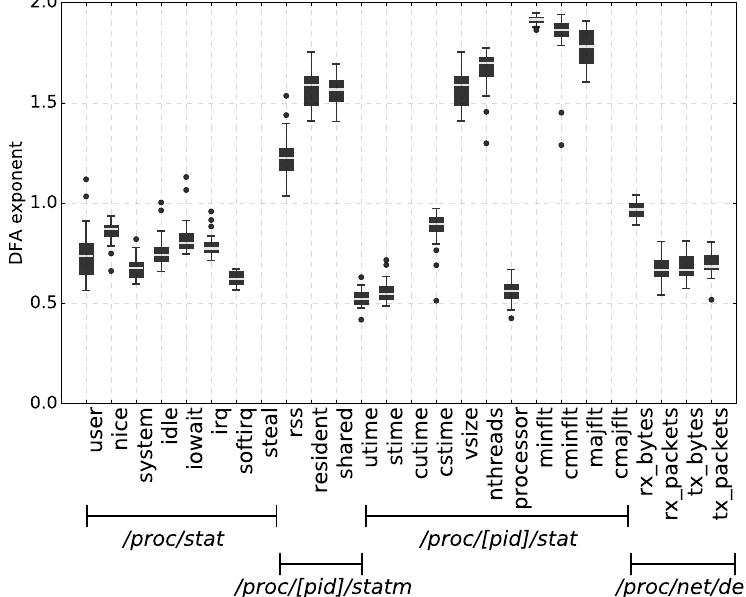
Figure 2. Box plot of the DFA exponents obtained from 30 independent executions for a randomly sampled malicious app, for each of the 26